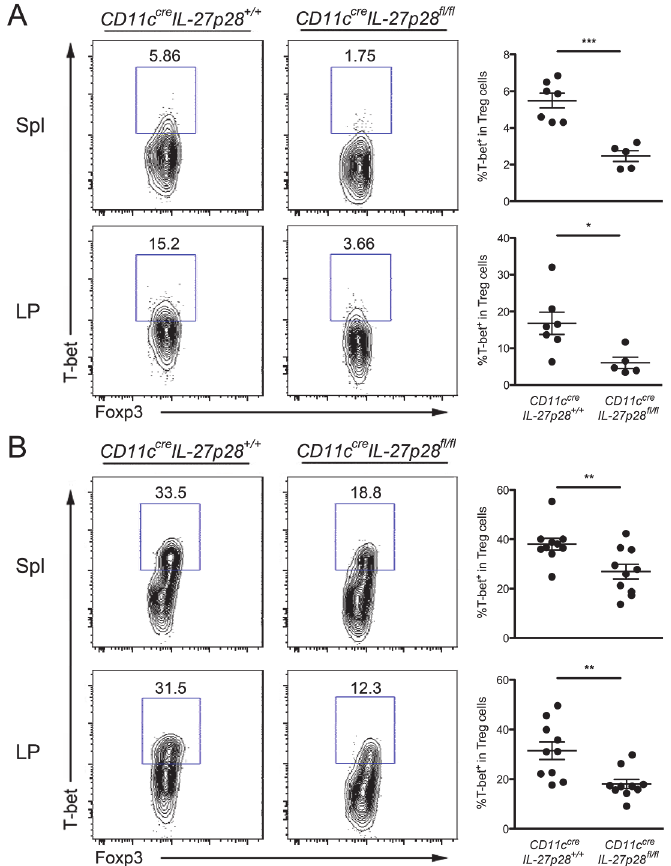
Foxp3 + CD4 + T cell population from spleen and LP in CD11c cre IL27p28 fl/fl mice and WT littermate controls (A) at steady state or (B) 8 days after T . gondii infection. FACS plots are representative of three